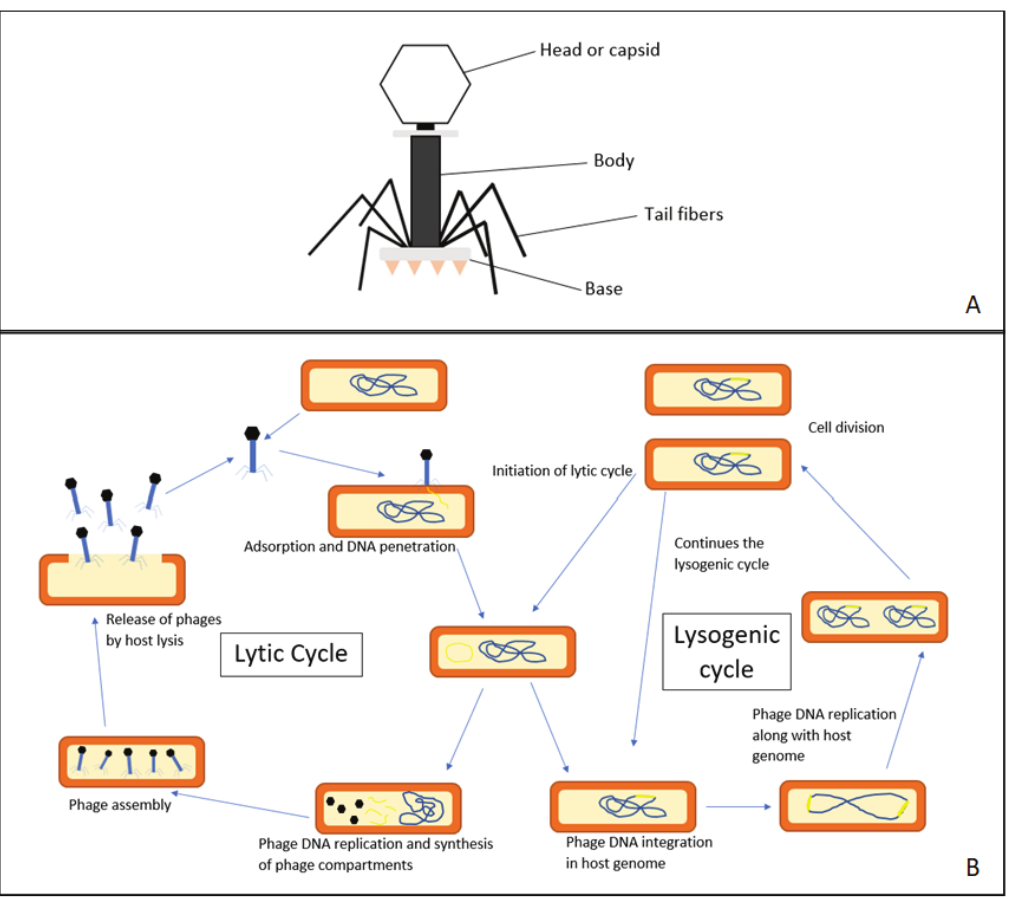
Figure 1: Bacteriophage and its life cycle. (A) The structure of a tailed bacteriophage; (B) The phage life cycle: lytic and lysogenic